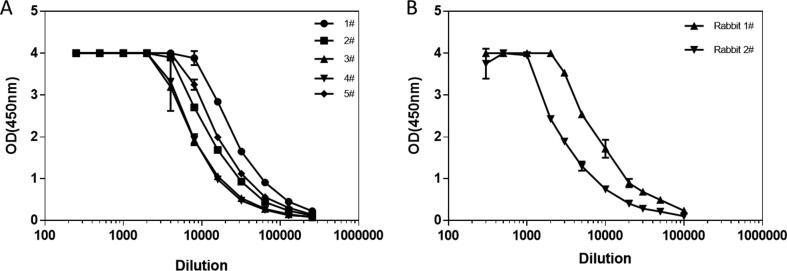
Anti-SARS-CoV-2 S1 antibody levels in S1-Fc immunized mice and rabbits. A) Serum samples collected from different mice were evaluated with S1-6 × His coated plates by ELISA using mouse IgG-specific secondary antibodies. The horizontal coordinate is dilution and the vertical coordinate is absorbance value at 450 nm. B) Serum samples collected from different rabbits were evaluated with S1-6 × His coated plates by ELISA using rabbit IgG-specific secondary antibodies. The horizontal coordinate is dilution and the vertical coordinate is absorbance value at 450 nm.